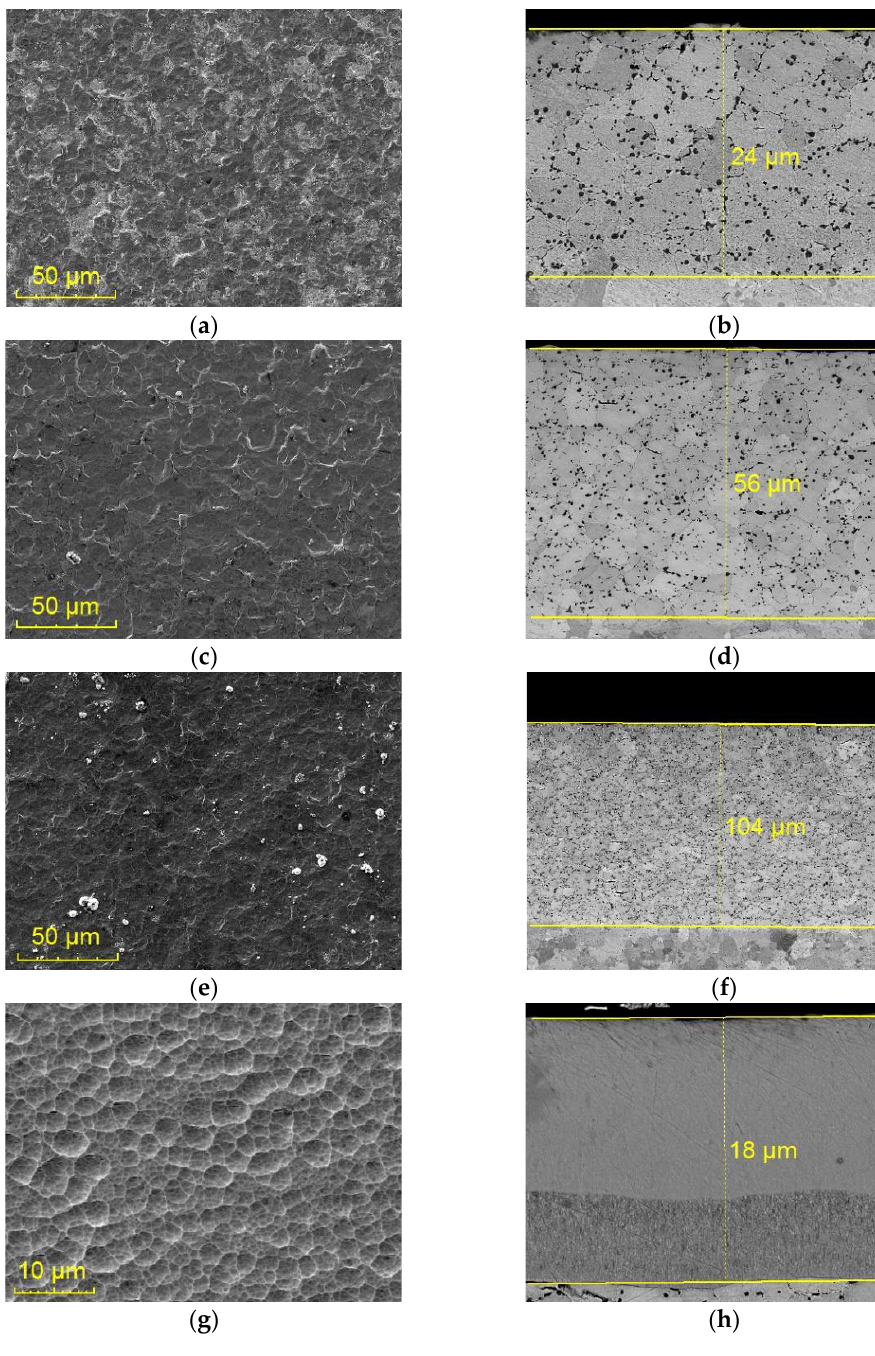
Figure 4. Representative view of 20Kh13 steel with nitriding type I ( a , b ), with nitriding type II ( c , d ), with nitriding type III ( e , f ), with Cr – CrC based coating ( g , h ).